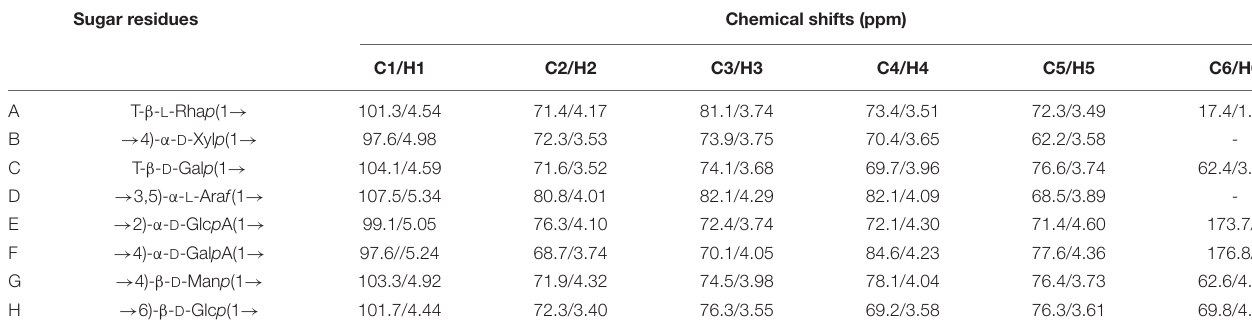
TABLE 3 | Chemical shifts of resonances in the 1 H and 13 C NMR spectra of SHP-2. Sugar residues Chemical shifts